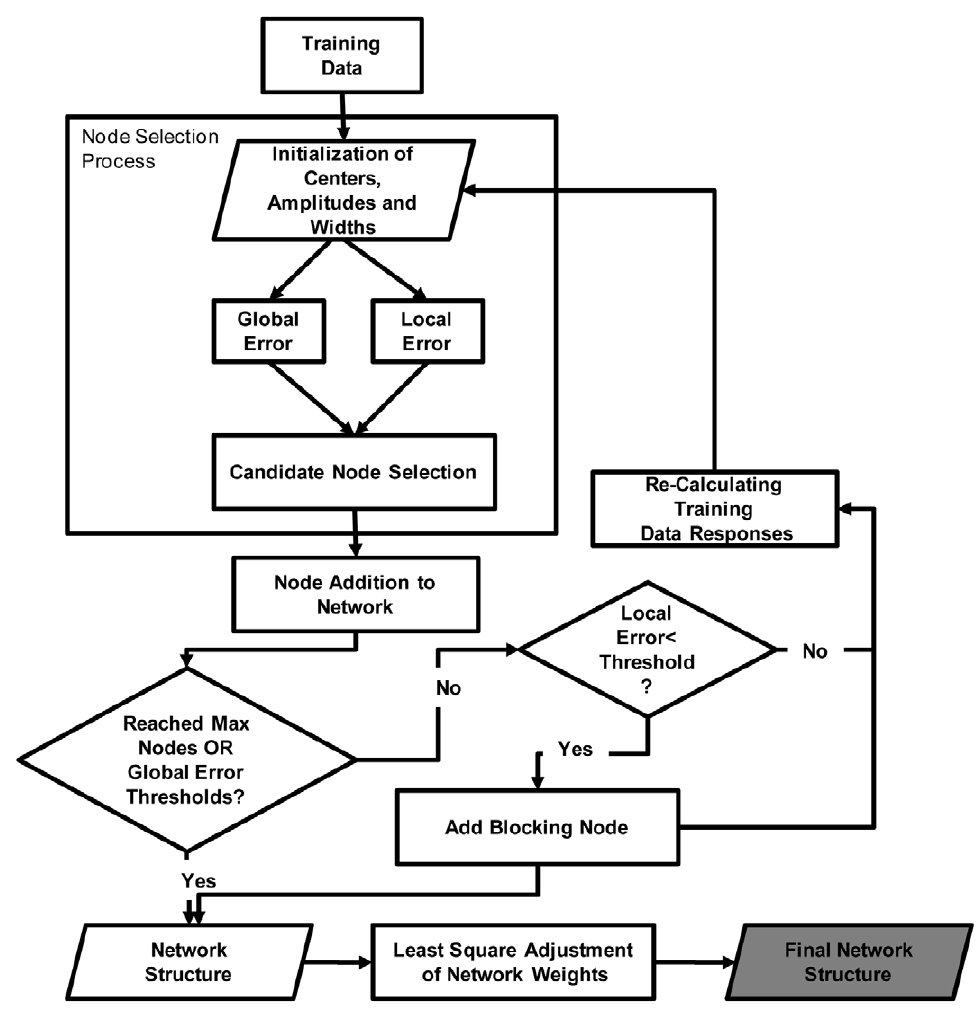
Figure 5. Schematic representation of training procedure.